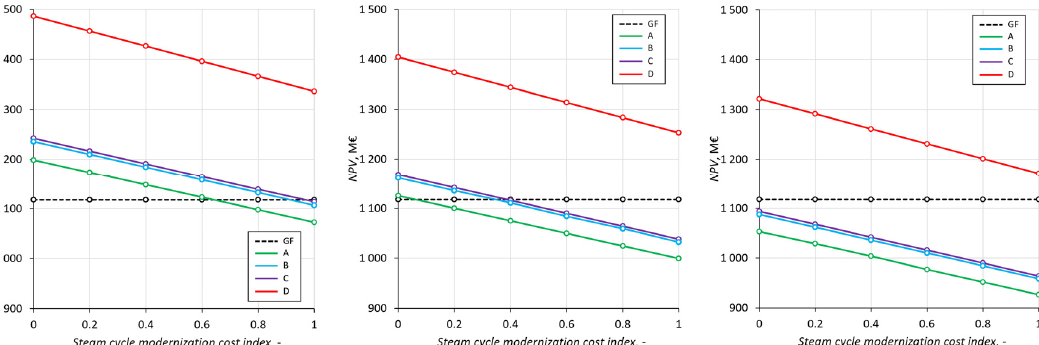
Figure 19. NPV as a function of steam cycle modernization cost index for the three values of retrofit savings factor ( left —maximum, central —average, right —minimum).